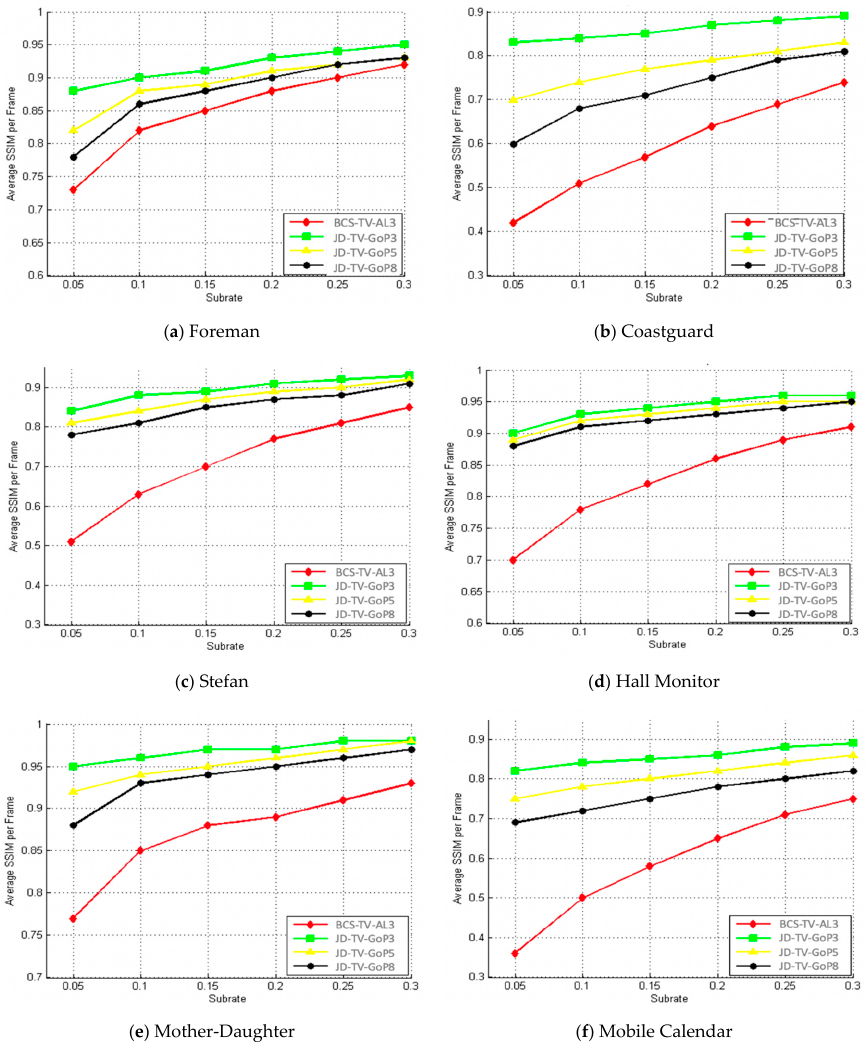
Figure 5. Average SSIM evaluation at GoP sizes of 3, 5, and 8 for different video sequences at different subrates for independent BCS-TV-AL3and proposed JD.